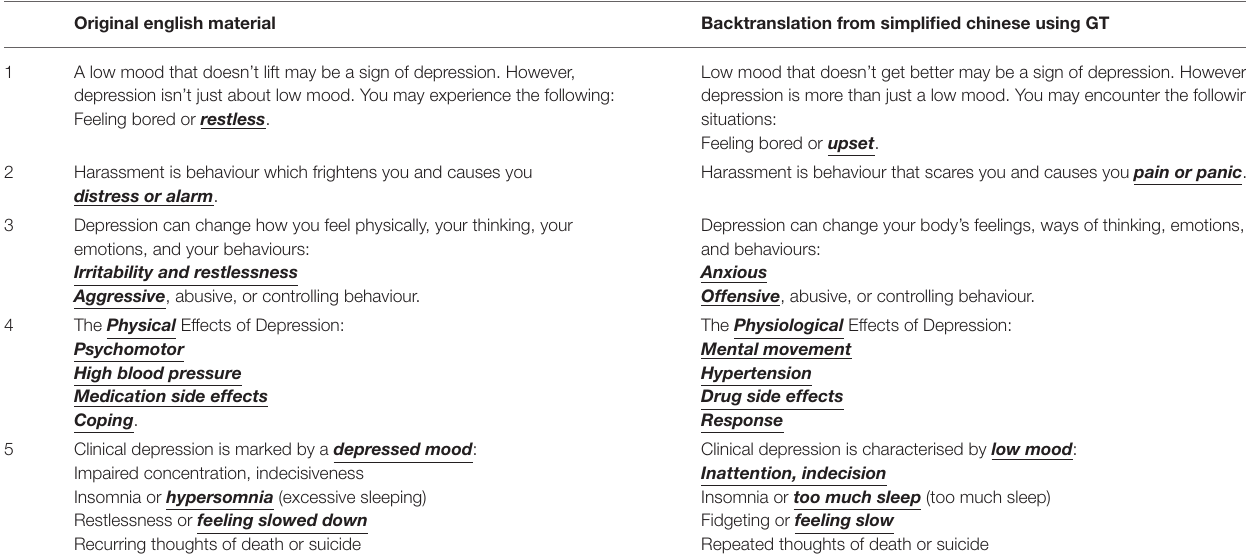
TABLE 2 | Examples of diagnosis related errors in NMT